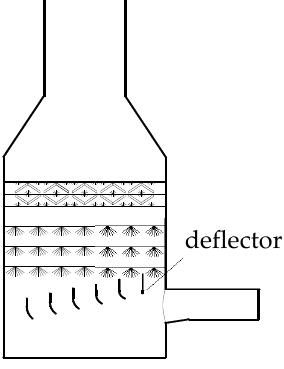
Figure 10. The schematic diagram of the installation of deflectors installed in the tower.